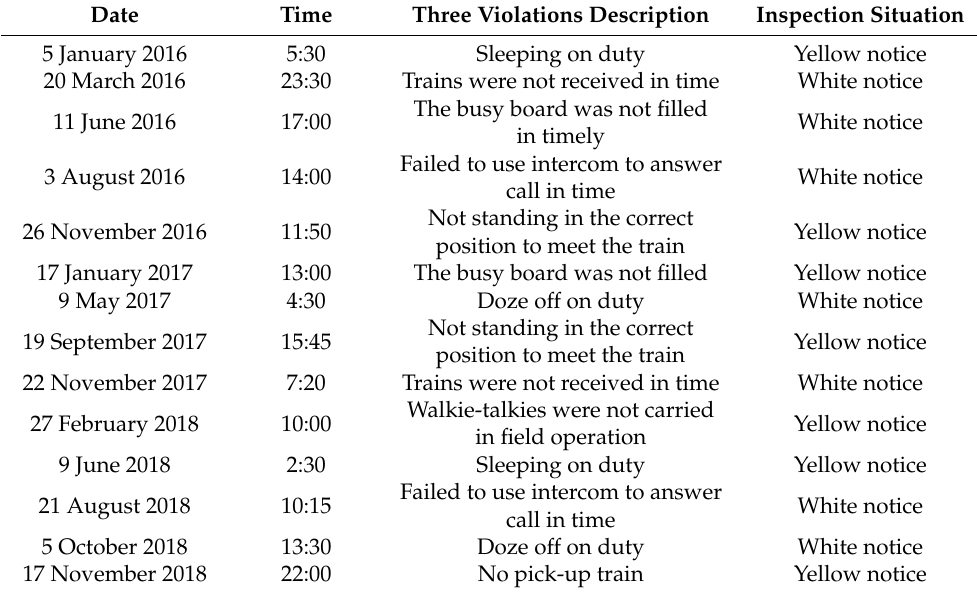
Table 14. Three violations data of “the assistant watchman did not appear as required”